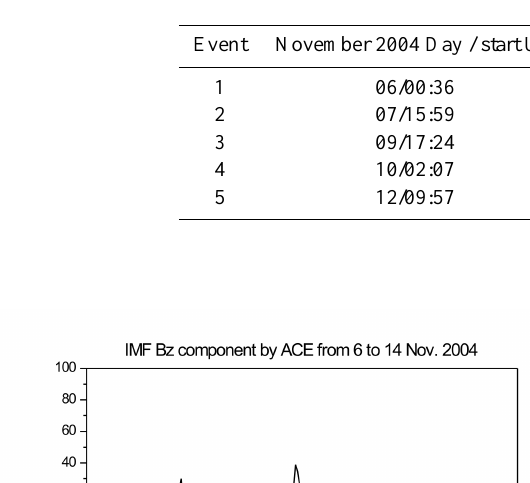
Table 4. Sequence of large flares recorded in NOAA Active Region 696.